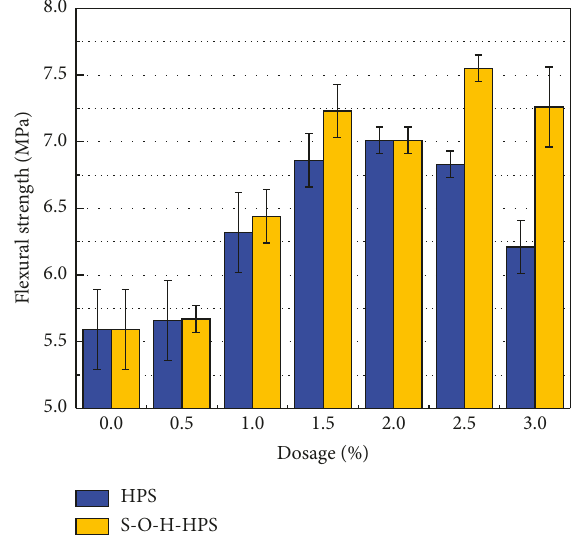
Figure 7: Effect of additives on elastic modulus of cement paste.